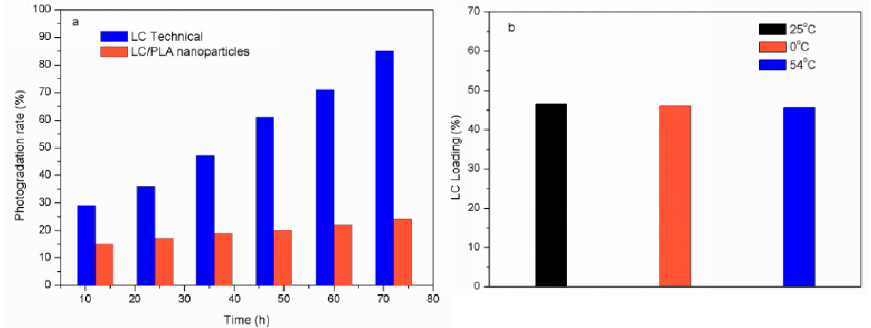
Figure 11. Comparison of ( a ) the LC photolysis percentage of the LC/PLA nanoparticles and the technical LC under UV irradiation, and ( b ) LC contents of the LC/PLA nanoparticles before and after 0 ◦ C for 7 days and 54 ◦ C for 14